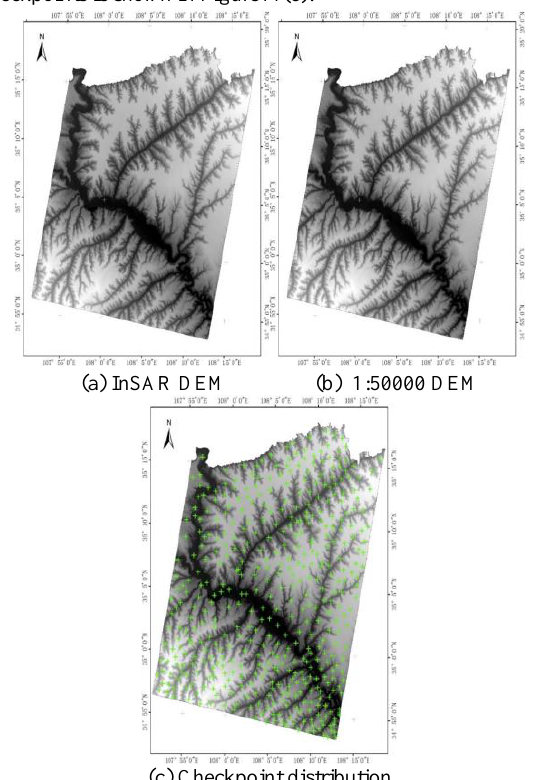
Figure 11. The registered InSAR DEM and 1: 50,000 DEM